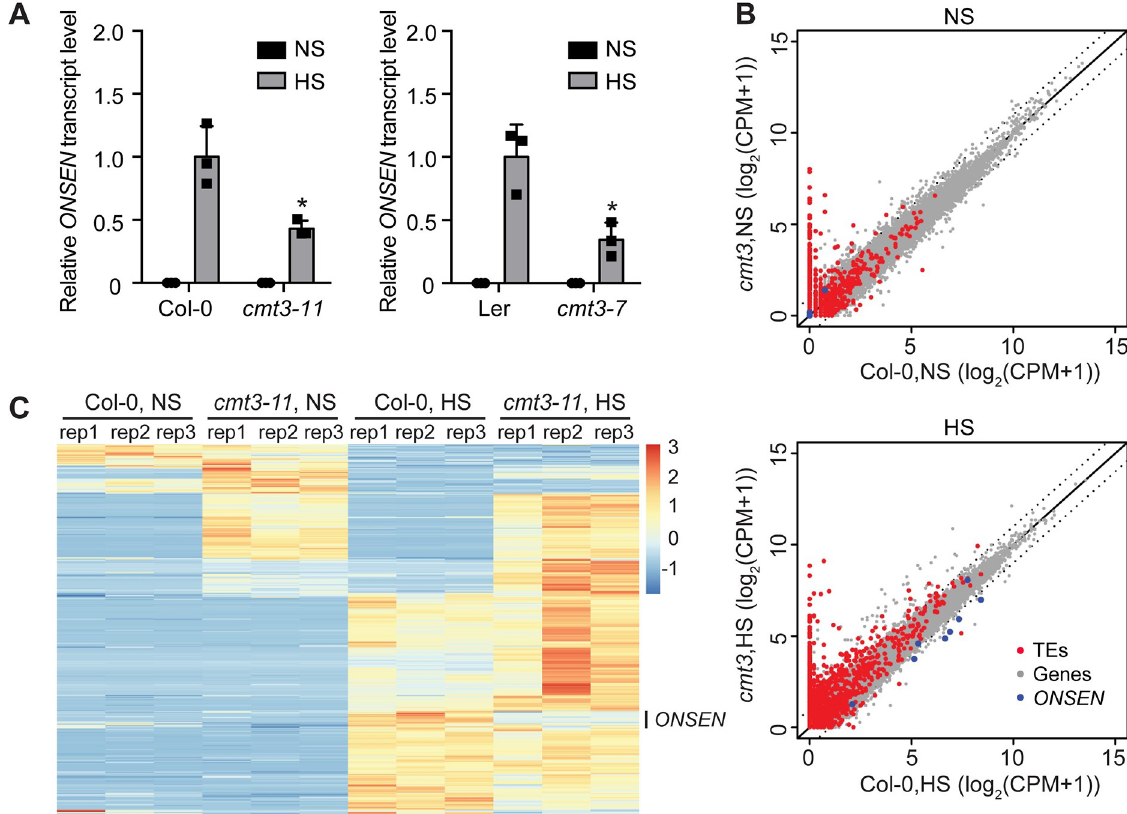
Fig 1. Heat-induced ONSEN transcript accumulation is dampened in cmt3 mutants. (A) RT-qPCR of ONSEN transcripts in cmt3 mutants from Columbia-0 ( cmt3-11 , left) and Landsberg erecta ( cmt3-7 , right) backgrounds under non-stress (NS) and heat stress (HS). The ONSEN transcripts were normalized to 18S rRNA . All bars represent mean + SD from three biological replicates. Student’s t -test. � P < 0.05. (B) The scatterplots of count per million reads (CPM) of protein-coding genes and transposable elements (TEs) in cmt3 versus Col-0 under NS (top) and HS (bottom). Dash lines indicate two-fold changes. (C) Heat maps of differentially expressed TEs in Col-0 and cmt3-11 under NS and HS from three biological replicates (rep1 to rep3). Color bar indicates the Z-score.